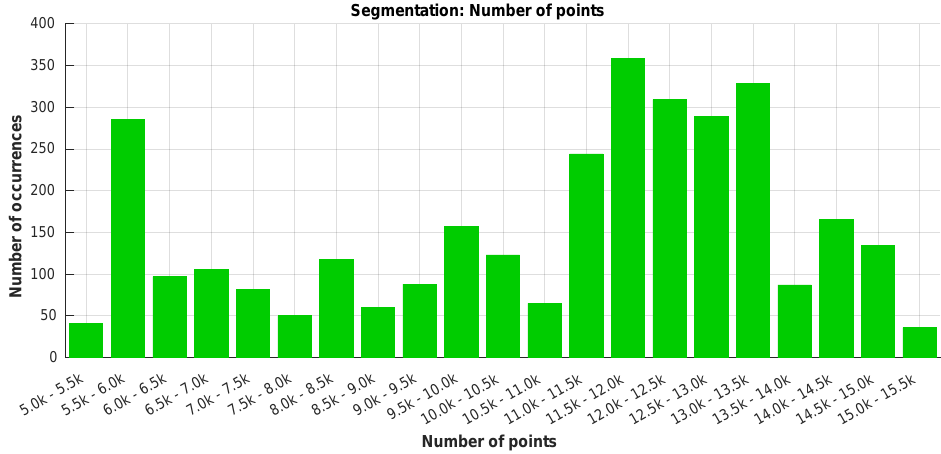
Figure 20. Number of points occurrences in the segmentation step.